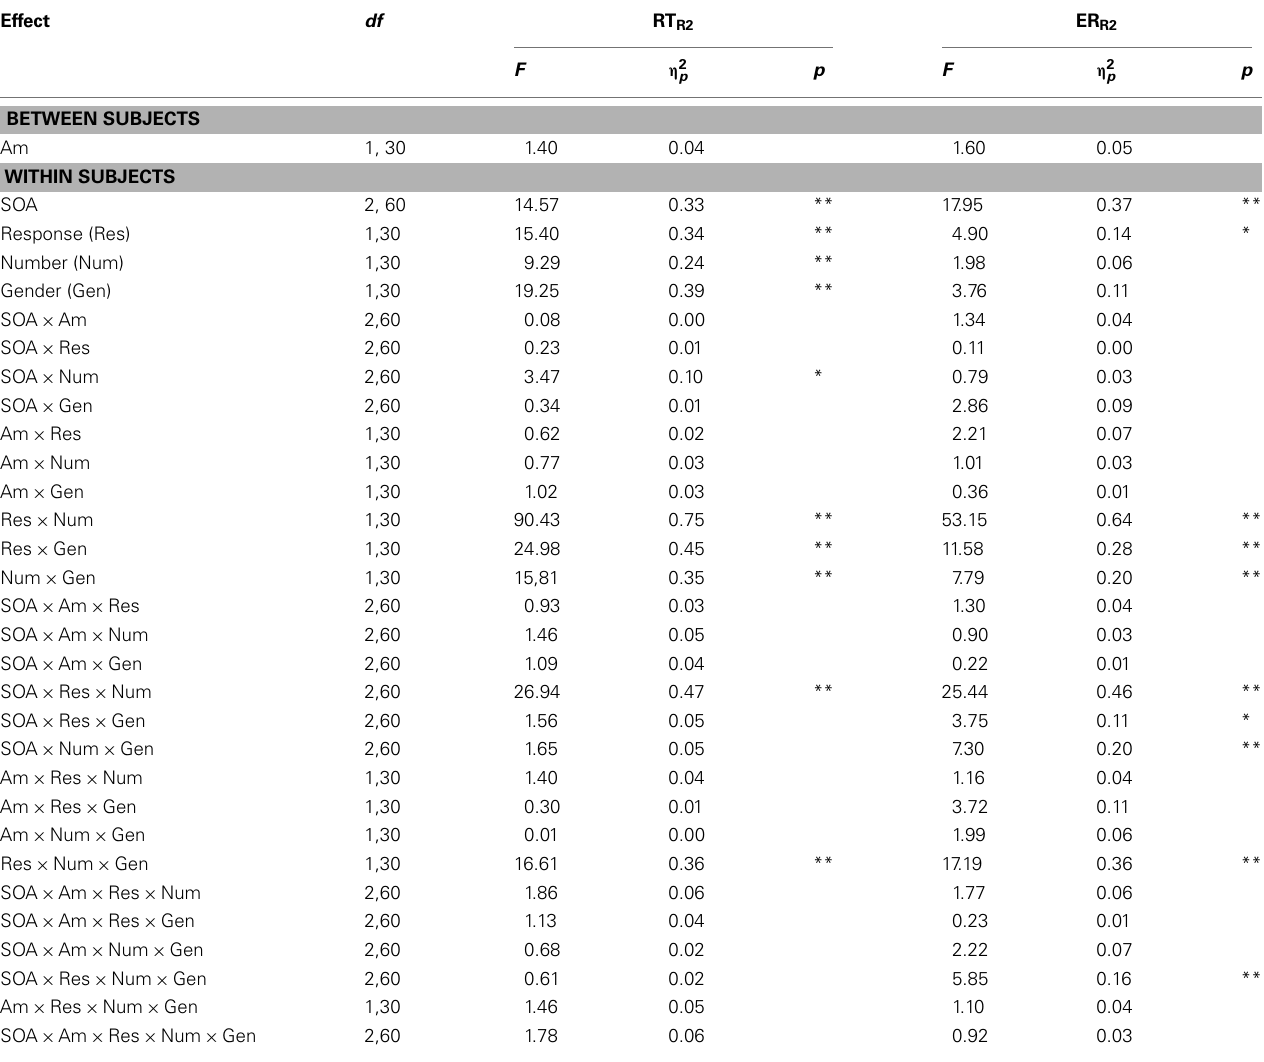
TableA4 | Results of analysis of variance on mean reaction time of correct responses (RT) and error rates (ER) for Experiment